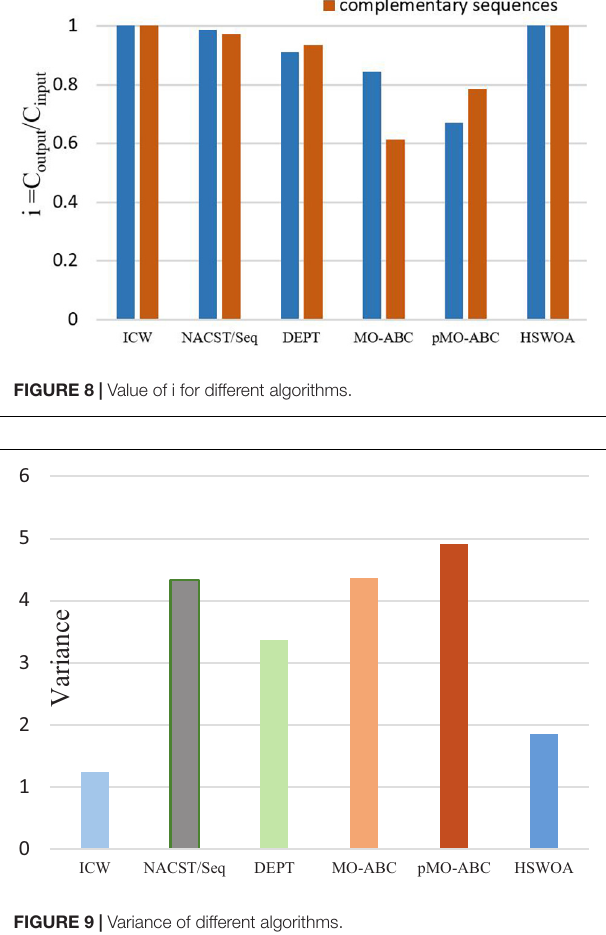
experiments are performed at room temperature, so the temperature was set at 25 ◦ C. We input the seven sequences (optimal sequences of each algorithm) of different algorithms in Table 3 into NUPACK. After evaluation, the values of C input and C output were calculated, and the value of i was obtained, as shown in Figure 8 .